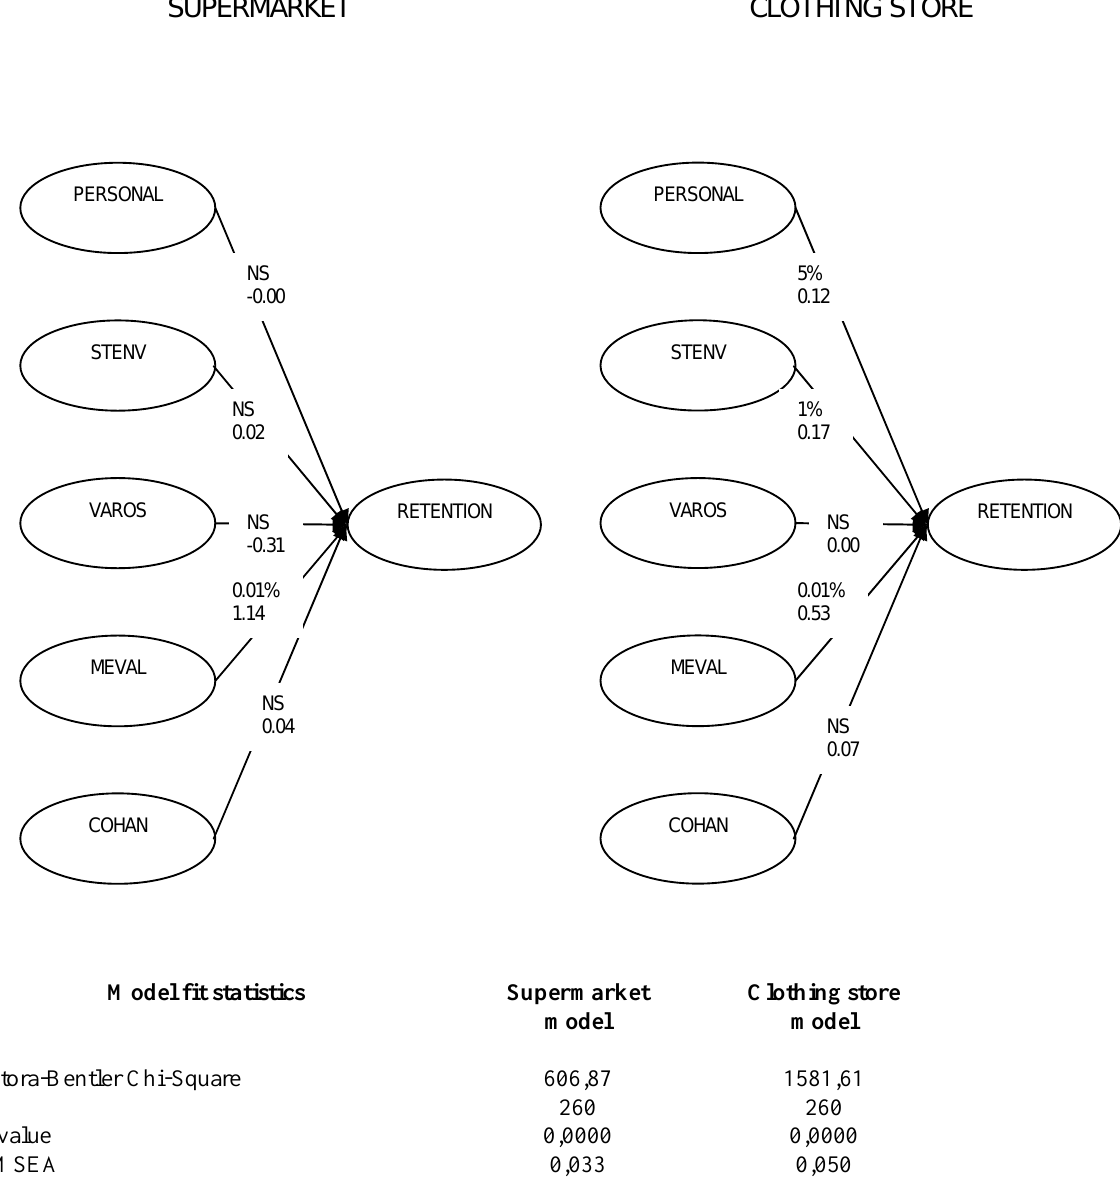
Figure 2: Relationships between the ISE dimensions and retention for supermarket and clothing store